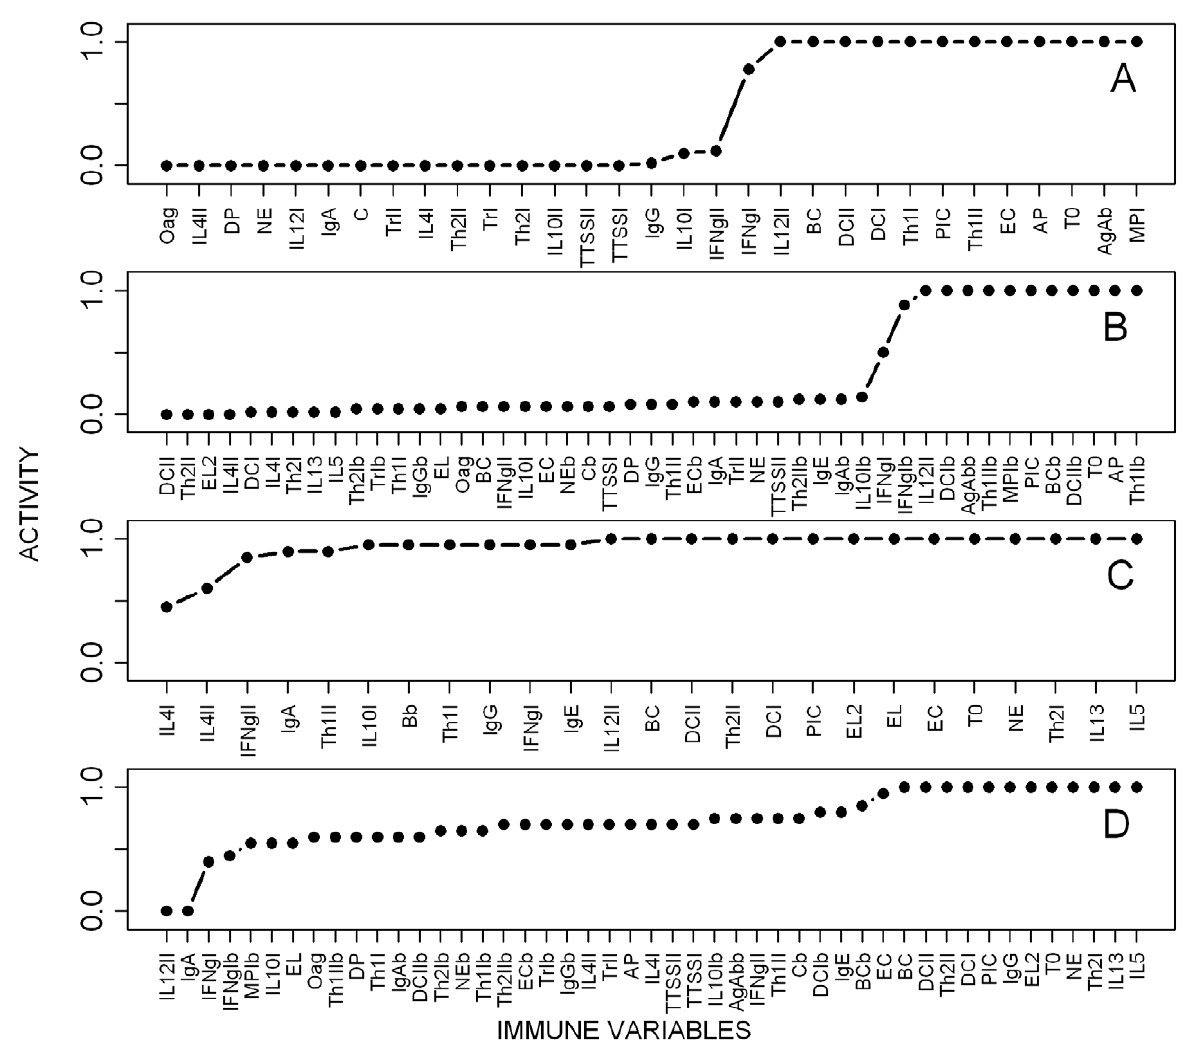
Figure 4. Parasite activity at the 20 th time step from simulations where network nodes were individually knocked out (from 100 replicates). A - B. bronchiseptica in single infection. B - B. bronchiseptica in co-infection. C - T. retortaeformis in single infection. D - T. retortaeformis in co-infection. Explanation of the abbreviations is reported in Figure 1, Figure 2 and Text S1.